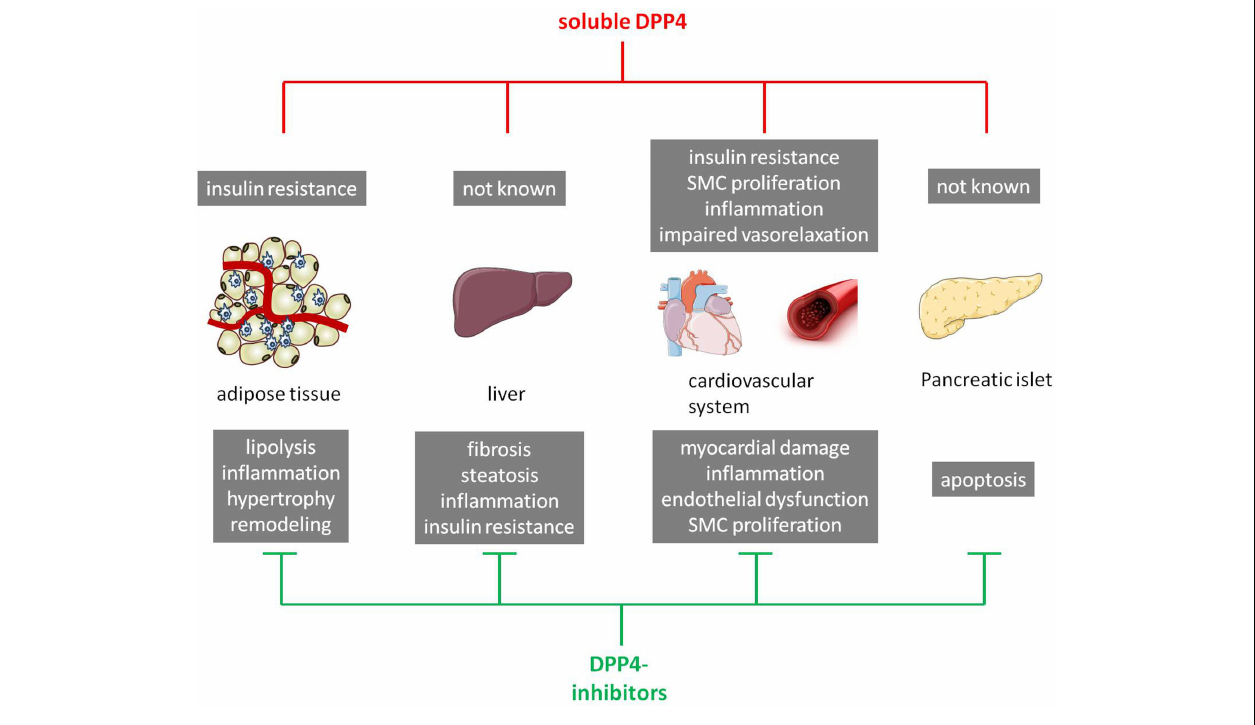
presented (gray boxes). The lower panel shows known effects of DPP4 inhibitors (in green) in these particular organs/tissues (gray boxes). SMC, smooth muscle